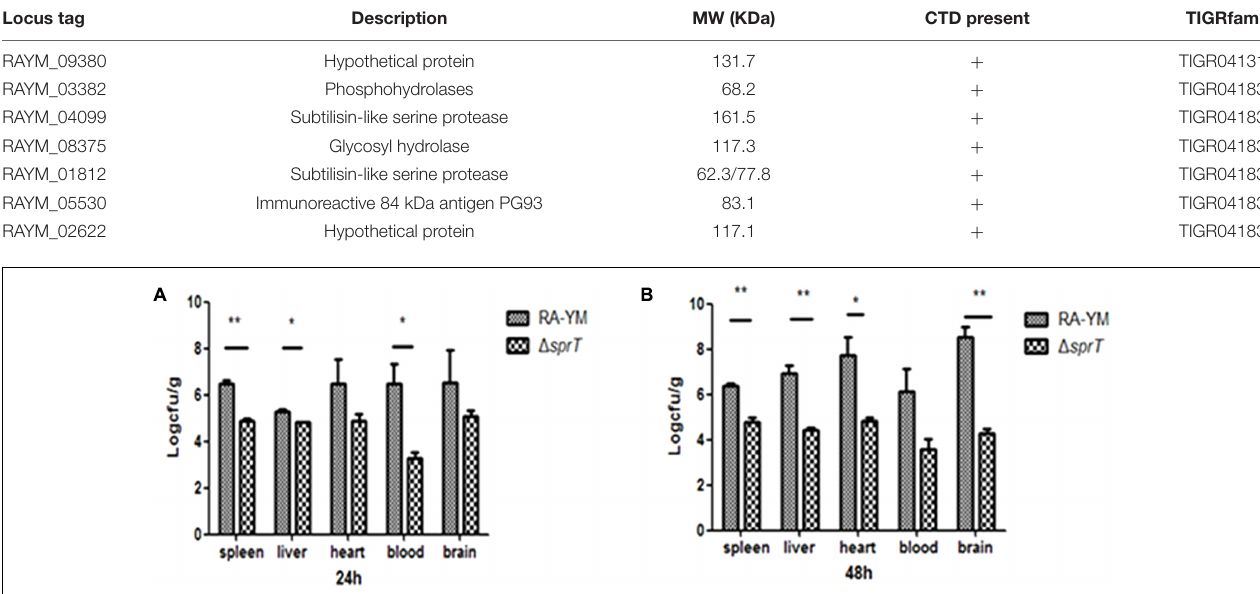
TABLE 2 | C-terminal domains (CTDs) of proteins identified in zymogram gels of RA-YM. Locus tag